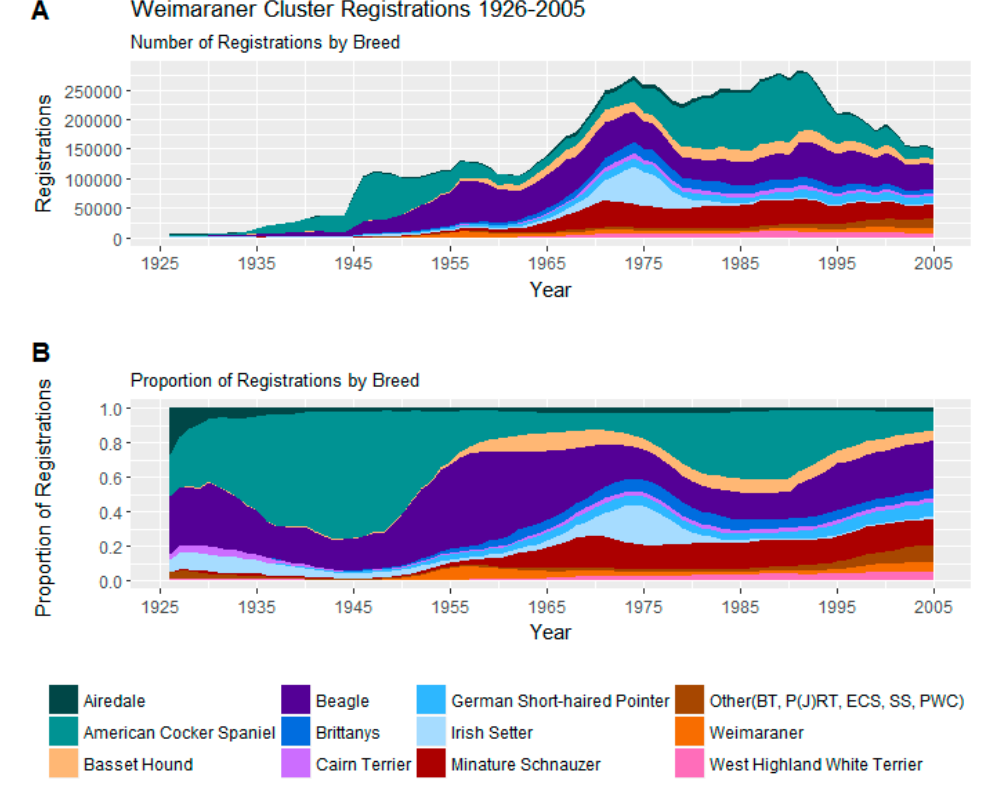
Figure 4. ( A ) Number of registrations; ( B ) and proportion of registrations within the Weimaraner Cluster. BT = Border Terrier, P(J)RT = Parson (Jack) Russell Terrier, SS = Standard Schnauzer, PWC = Pembroke Welsh Corgi.